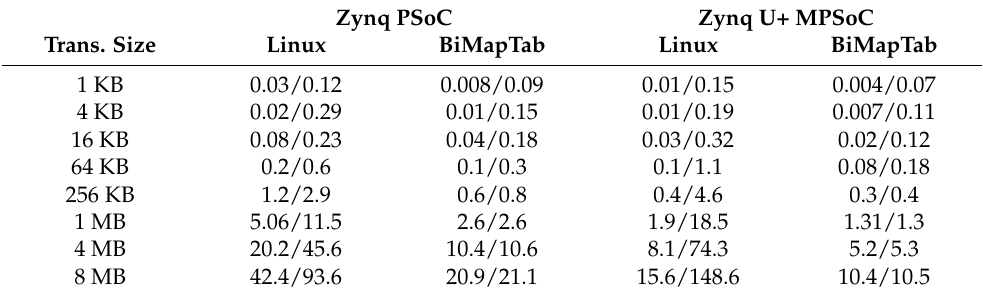
Table 1. AXI-DMA transfers time (ms) for the Linux native driver and proposed software API. Zynq PSoC Zynq U+ MPSoC Trans. Size Linux BiMapTab